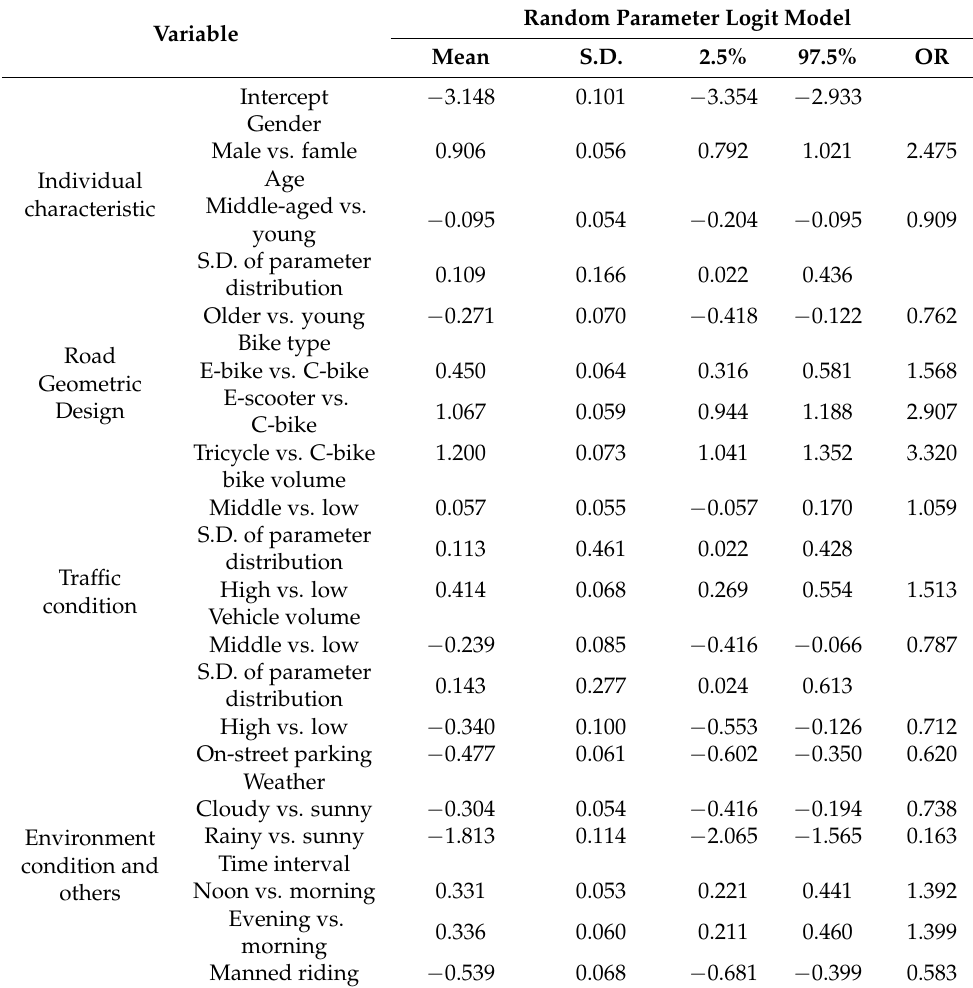
Table 5. Estimation from the Bayesian random parameters logit model at bike lanes separated with